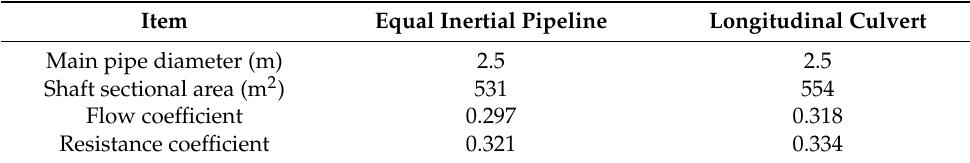
Figure 5. Risk analysis and optimization process of water surface deviation from the shafts. Table 2. Characteristic parameters of the filling–emptying system.